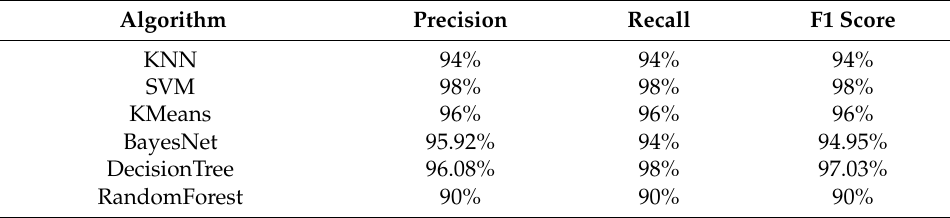
Table 2. Results of different detection algorithms. Algorithm